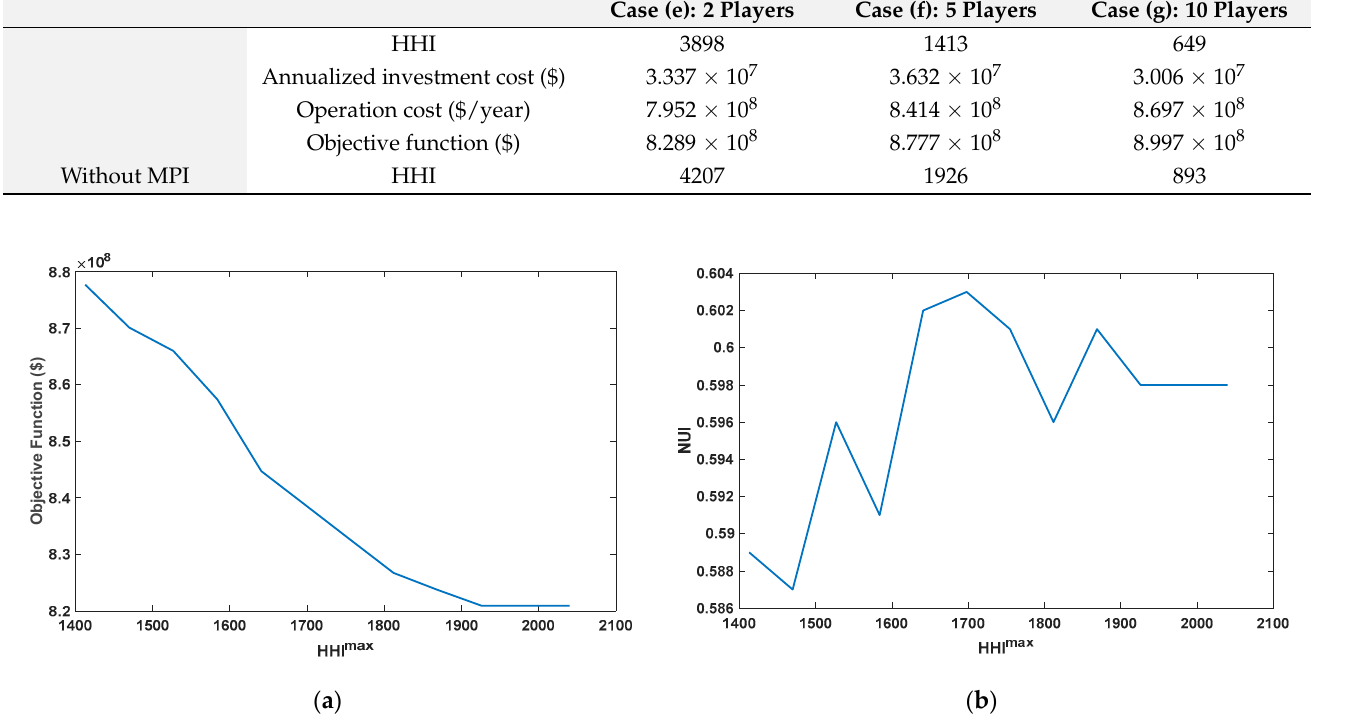
Figure 3. ( a ) Objective function and ( b ) NUI versus different values of HHI max for the number of players being 5.